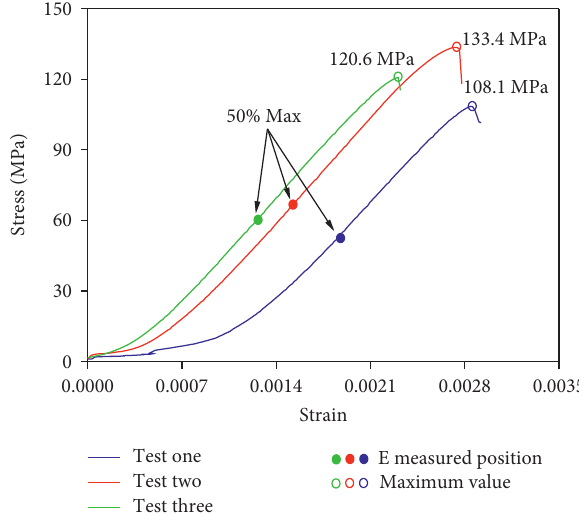
Figure 7: The stress-strain curve obtained from compression test.